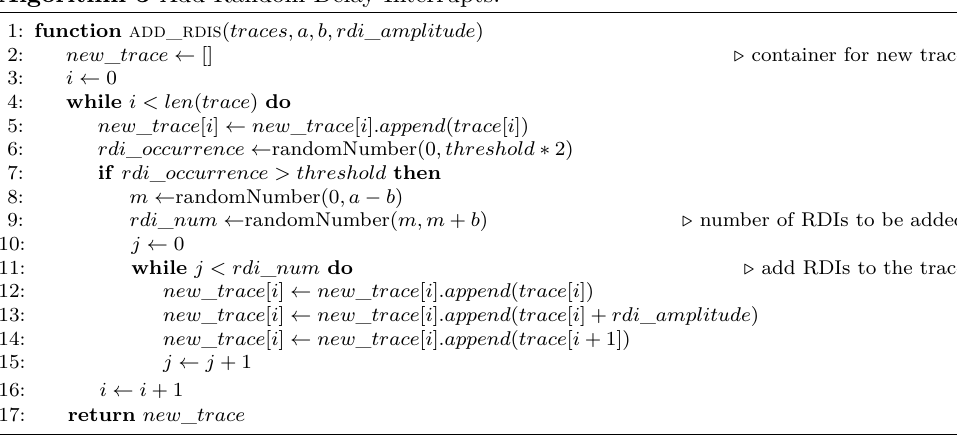
Algorithm 3 Add Random Delay Interrupts.